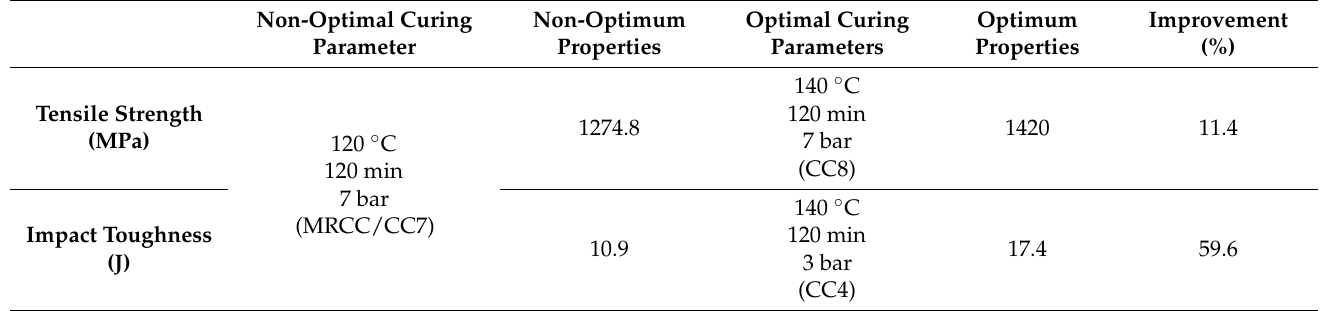
Table 6. A comparative summary of non-optimum and optimum properties. This table compares MRCC (non-optimal) curing parameters and non-optimum properties with optimal curing parameters and optimum